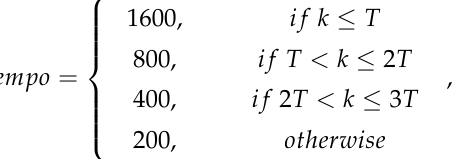
Figure 5. Volume control: ( a ) Vector length; ( b ) Static case.